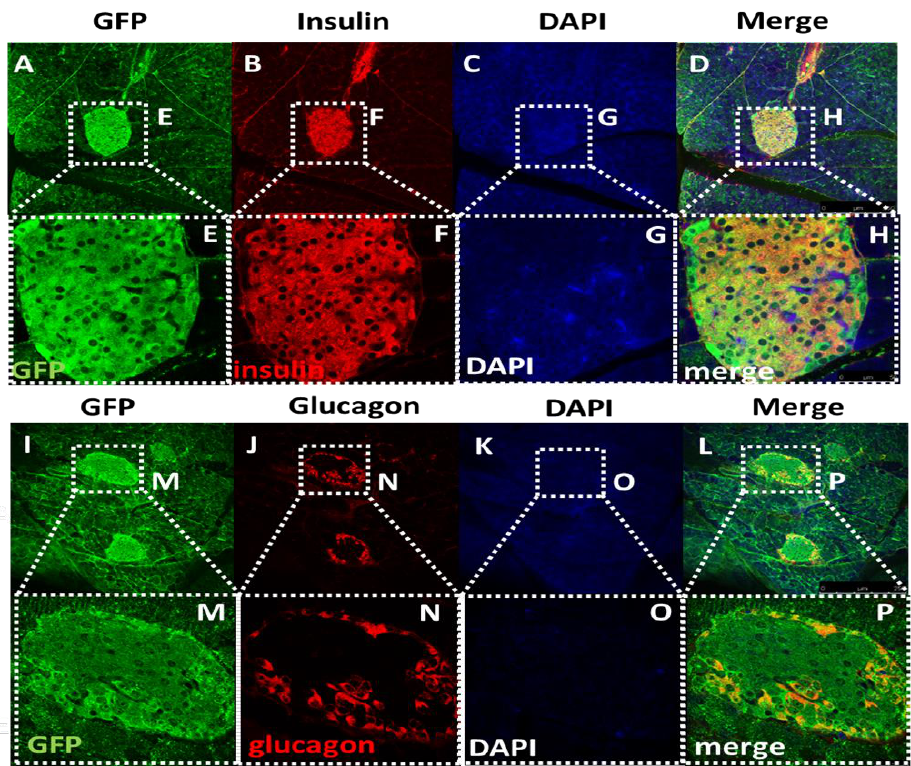
Figure 1. Islet immunofluorescence staining of GFP, insulin, and glucagon. ( A – D ) Images of islets within pancreatic tissue display the expression of ( A ) GFP, ( B ) insulin, ( C ) DAPI, and ( D ) the merged image in Ghsr-IRES-tauGFP Knock-In mice (magnification: 100×). The co-localization of GFP with insulin supported the growth hormone secretagogue receptor (GHS-R) expressed in β -cells. ( E – H ) Enlarged images of islet expression of GFP, Insulin, DAPI, and the merged image of the panel ( A – D ) (magnification: 400×). ( I – L ) Images of islet within pancreatic tissue display the expression of ( I ) GFP, ( J ) glucagon, ( K ) DAPI, and ( L ) the merged image. The co-localization of GFP with glucagon supports that GHS-R is expressed in α -cells. ( M – P ) Enlarged image of islet expression of GFP, glucagon, DAPI, and the merged image of the panel ( I – L